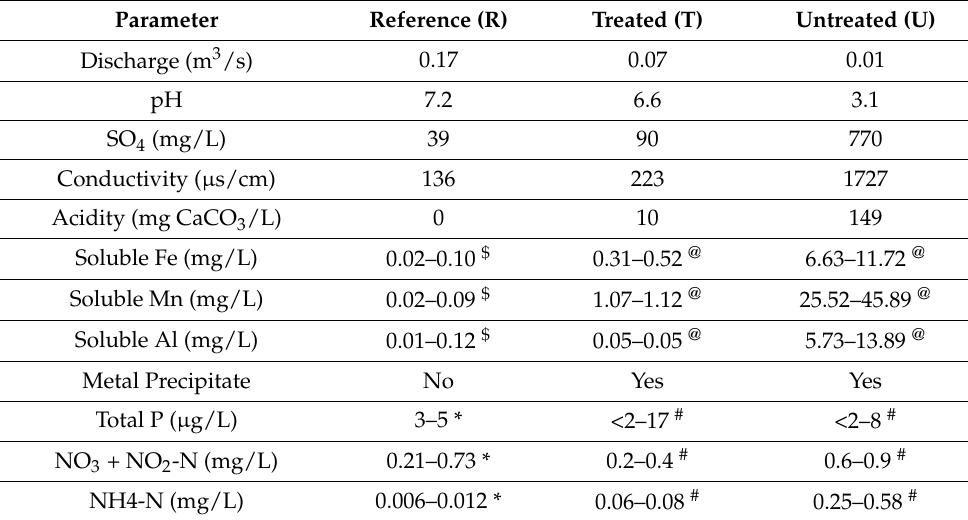
Table 1. Water chemistry parameters for the 3 stream sites. pH, SO 4 , conductivity and acidity were measured concurrently with microbial samples in this study. * Three samples in 2016. # Two